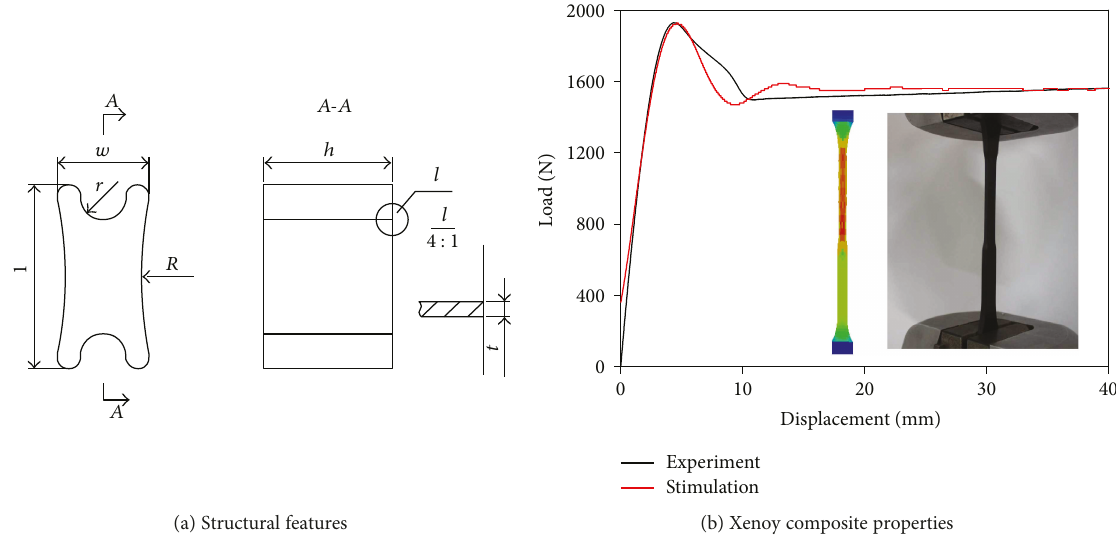
Figure 1: Structural features and material properties of a single X-shaped energy-absorbing